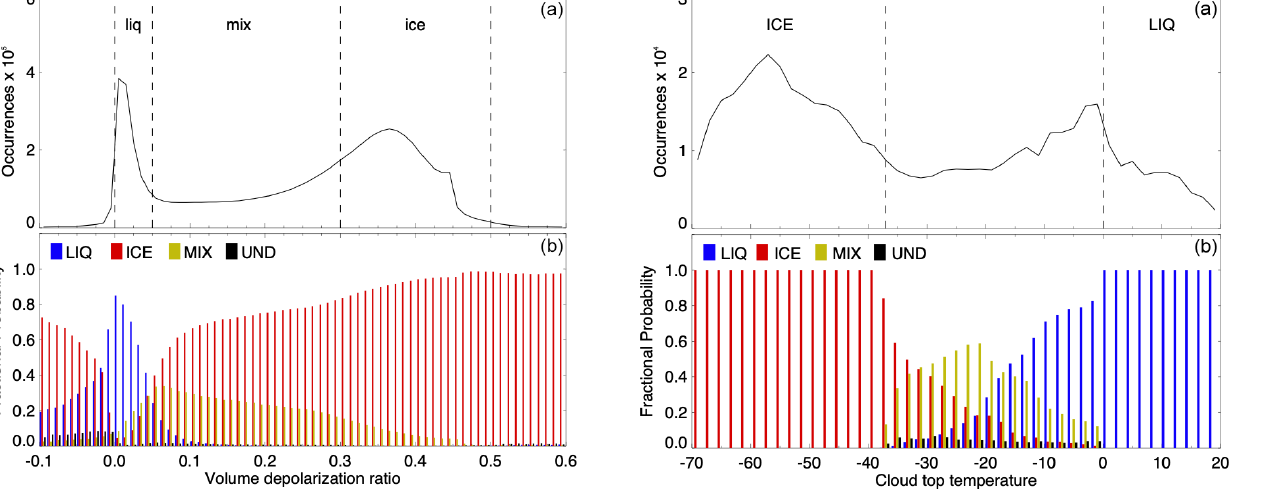
Figure 8. (a) Distribution of cloud top temperatures for all detected cloud layers at GSFC (2018–2019). The vertical dashed lines in- dicate the boundaries of the mixed-phase regime ( − 37–0 ◦ C). (b) Fractional probability of retrieved cloud phases in 2 ◦ C increments for the cloud top temperatures shown in (a)